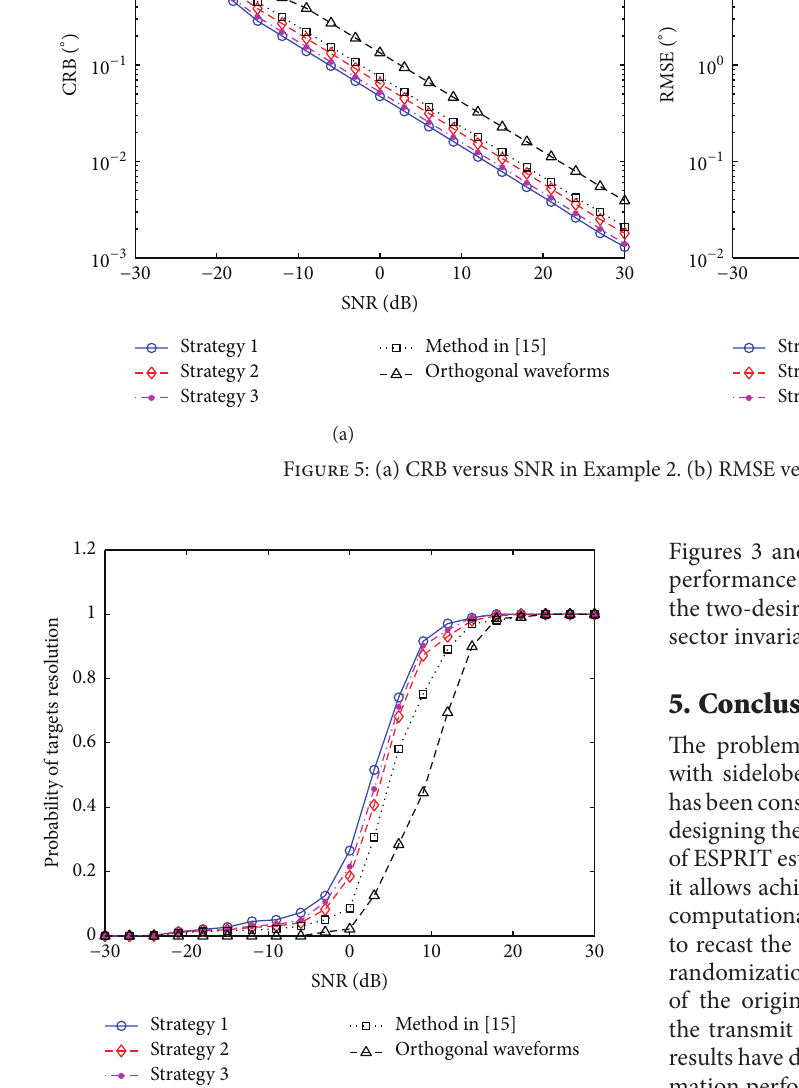
Figure 6: Probability of target resolution versus SNR in Example